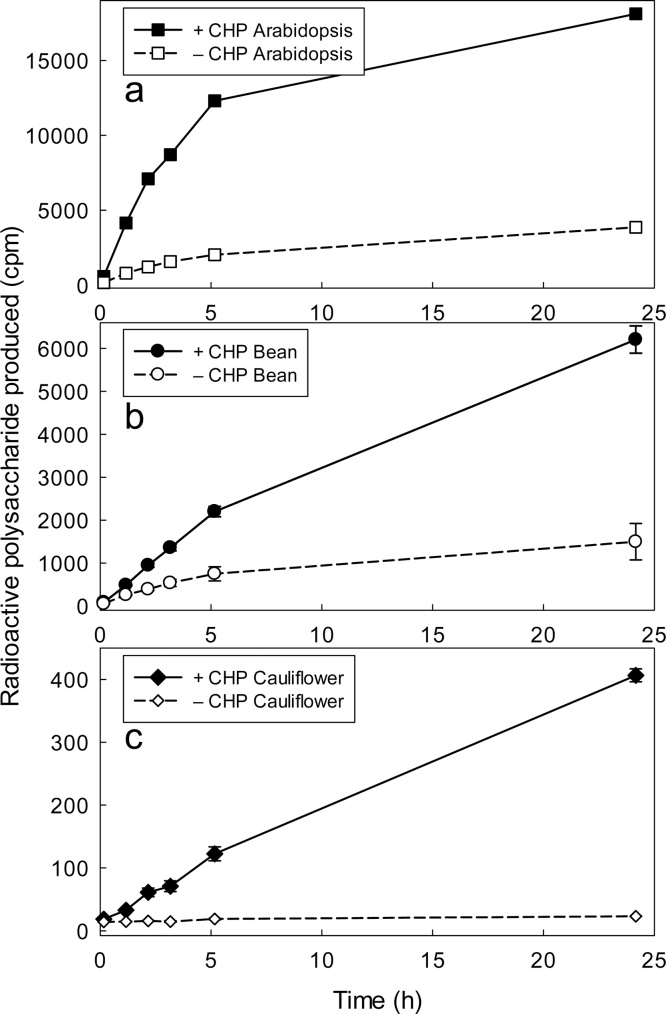
CHP activates wall-bound XTHs present in diverse plant tissues. Tissue from (a) 7-day suspension-cultured Arabidopsis cells, (b) mung bean shoots and (c) cauliflower florets was homogenised, frozen, thawed and copiously water-washed. The crude wall preparations, in PL-blocked PCR tubes, were gently shaken with standard XET reaction-mixture with or without CHP (1.5 mg/ml). At intervals the yield of soluble [3H]polysaccharide product was assayed. In this experiment, a yield of 100 cpm of 3H-polysaccharide indicates 1.2 pmol XXXGol incorporated.